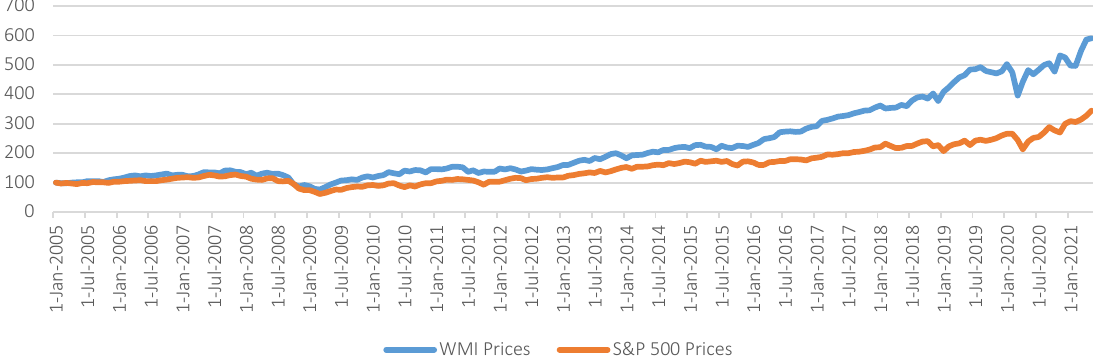
Figure 3. Price volatility for waste management stocks and the